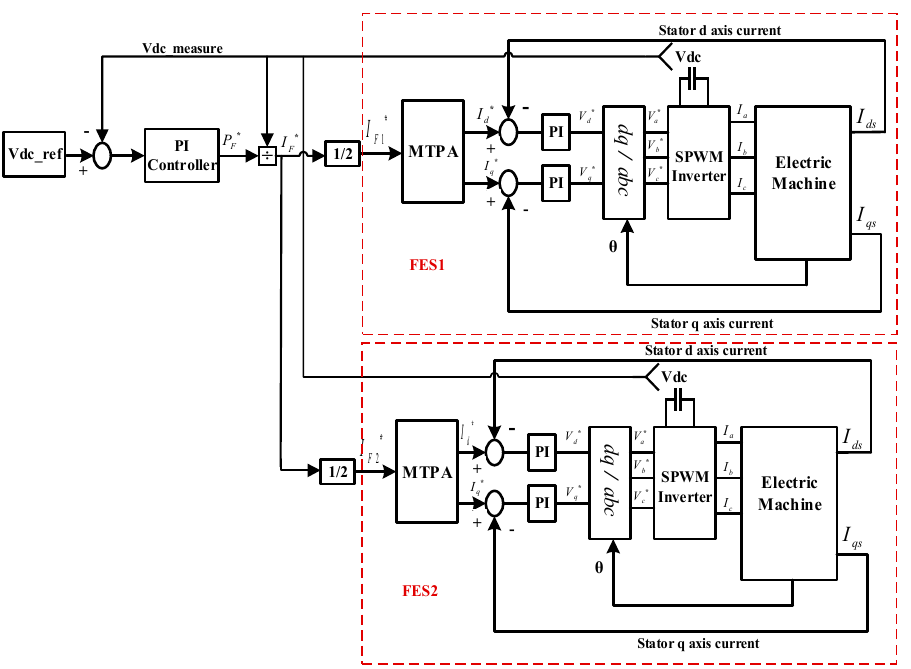
Figure 14. FESS control block diagram.